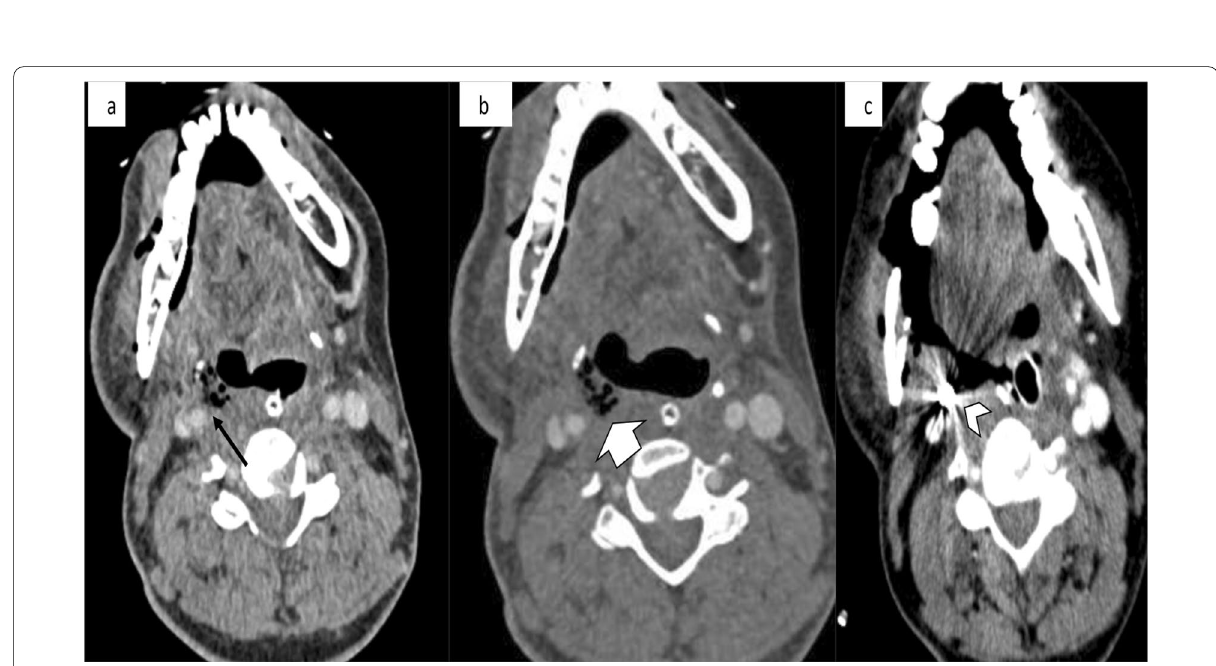
Fig. 6 Post-procedure computed tomography of face 4 days after embolization of case two ( a ) axial section demonstrates no contrast extravasation at the suspected site of external carotid breech indicating successful embolization (arrow). b Axial section shows the presence of air foci and no persistence of contrast in delayed section (open arrow). c Axial section shows the presence of microcoils in right external carotid artery